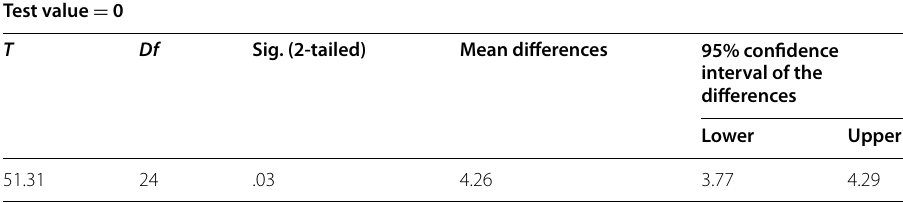
Table 11 Results of the attitudinal